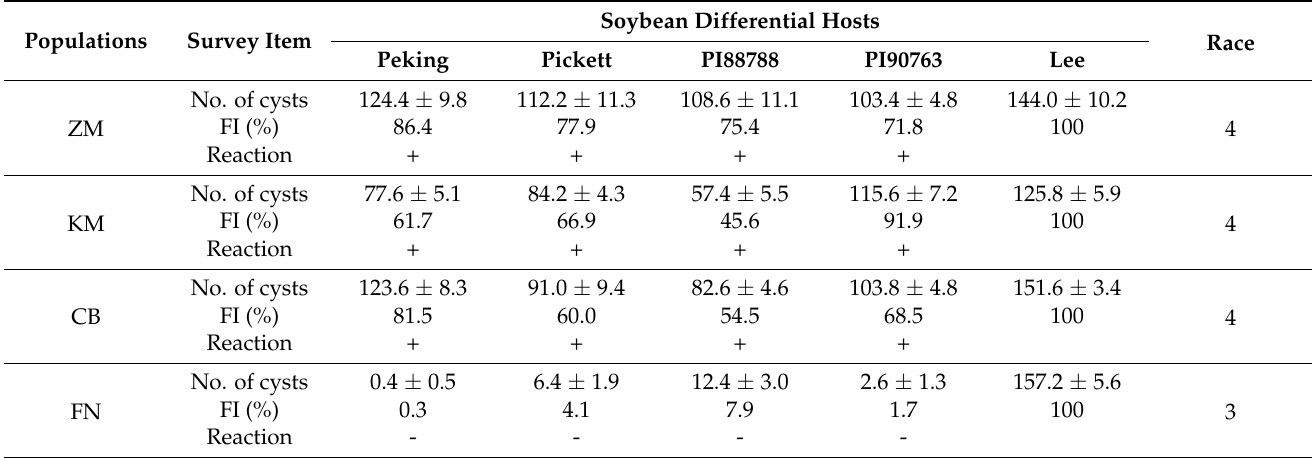
Table 3. Identification of Heterodera glycines races collected from the Bashang region of Hebei Province.